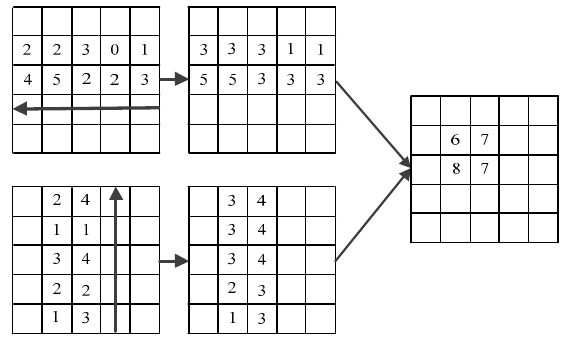
Figure 8. Process of corner pooling.